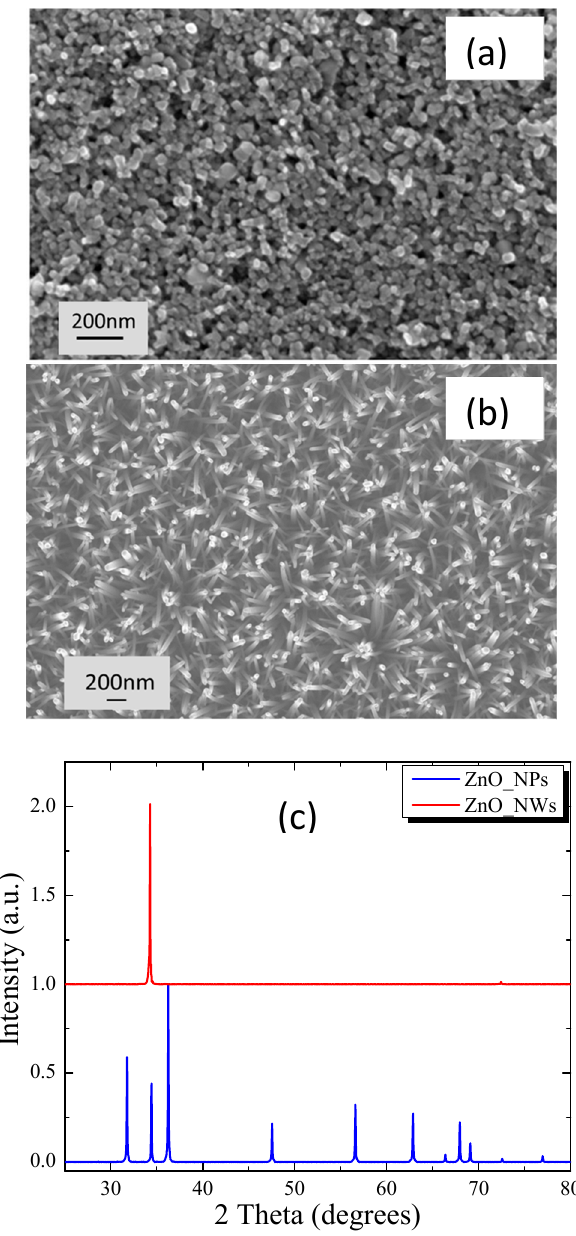
Figure 1. SEM images of: ( a ) ZnO nanoparticle film; and ( b ) a ZnO nanowire film; and ( c ) XRD patterns of a ZnO nanoparticle and a nanowire film.